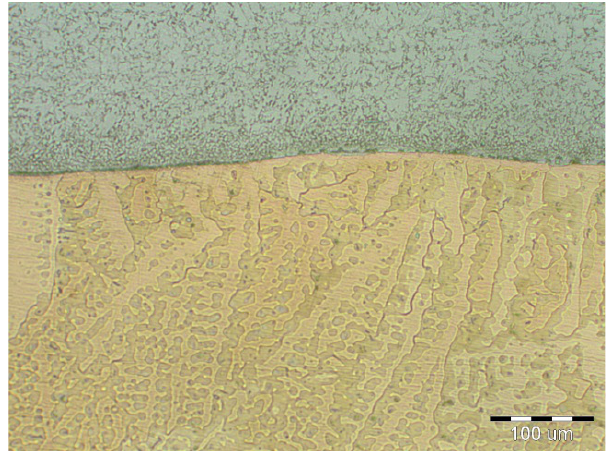
Figure 8. Dendritic microstructure of CuSn6P cladding.